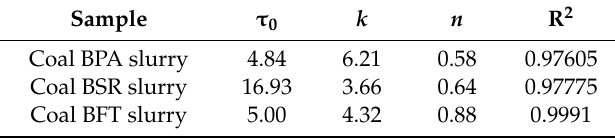
Table 2. Rheological index of different bio-oil coal slurry.